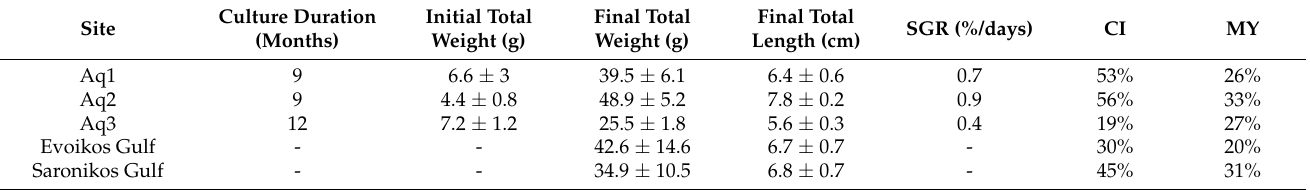
Table 3. Culture duration, initial total weight, final total weight, final total length, specific growth rate (SGR), condition index (CI), and meat yield (MY) at three IMTA farms of the pearl oyster Pinctada imbricata radiata (Aq1: Epidauros, Aq2: Evoikos, Aq3: Rhodes) and CI and MY of P. imbricata radiata under natural conditions the Evoikos and Saronikos Gulfs